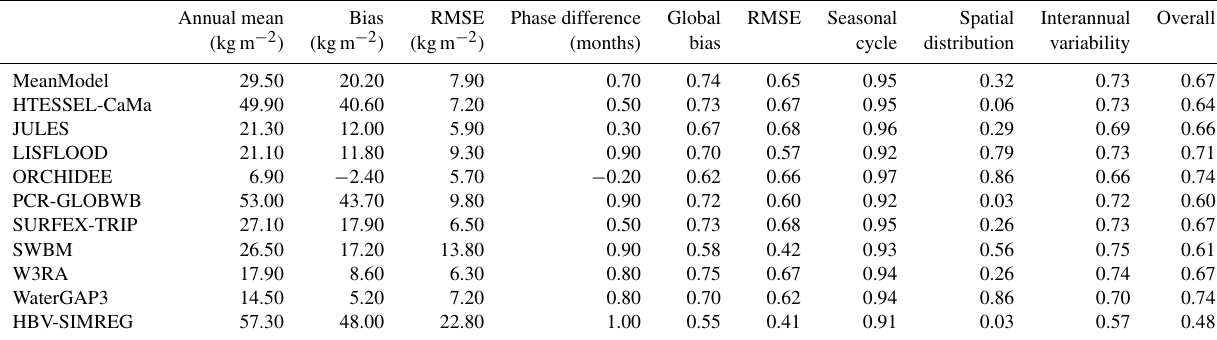
Table B4. Diagnostic summary for snow water equivalent: model vs. GLOBSNOW.